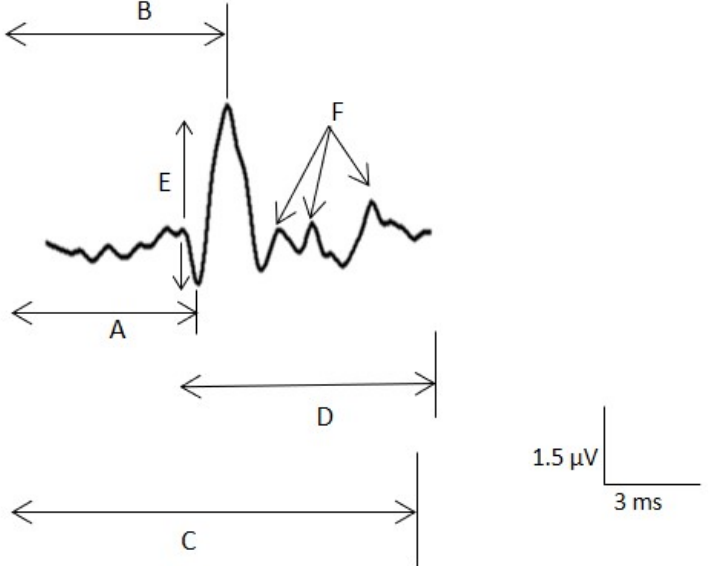
Figure 3. Sensory nerve action potential (SNAP) measurements. A. Latency to the main positive peak for the maximal nerve conduction velocity (NCV). B. Latency to the negative peak. C. Latency to the last negative for the minimal NCV. D. Duration of the potential. E. Peak-to-peak amplitude. F. Small components.